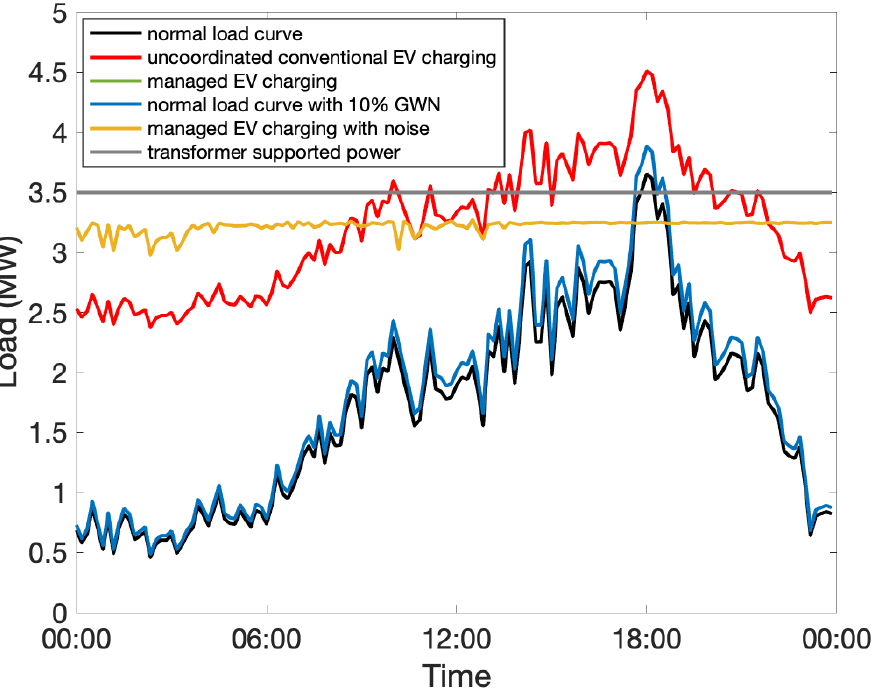
Figure 8. Comparison of load curves of different situations with 10%